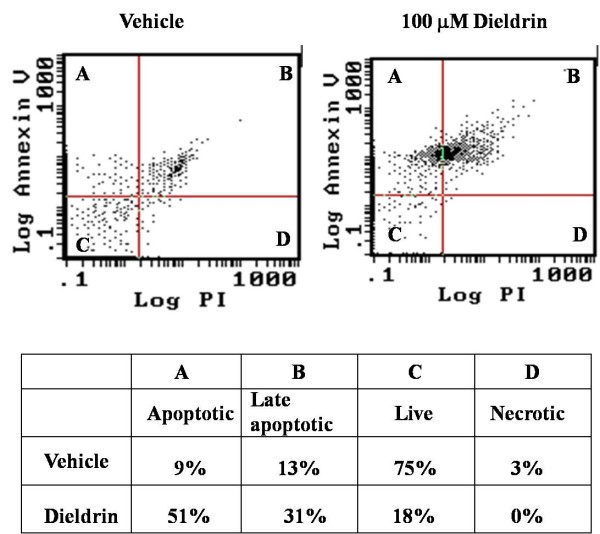
Dieldrin-induced apoptosis in N27 cells. N27 cells (~1 × 106 cells/ml) were treated with 100 μM dieldrin for 3 hr, and apoptotic cells were detected by flow cytometry as described in "Materials and Methods." Dual staining of cells with annexin-V-FITC and propidium iodide enabled categorization of cells into four regions (A, B, C, and D). Region A was apoptotic cells, B was apoptotic and necrotic cells, C was live or healthy cells, and D was necrotic cells. The experiment was repeated three times and data represent the average of each region.